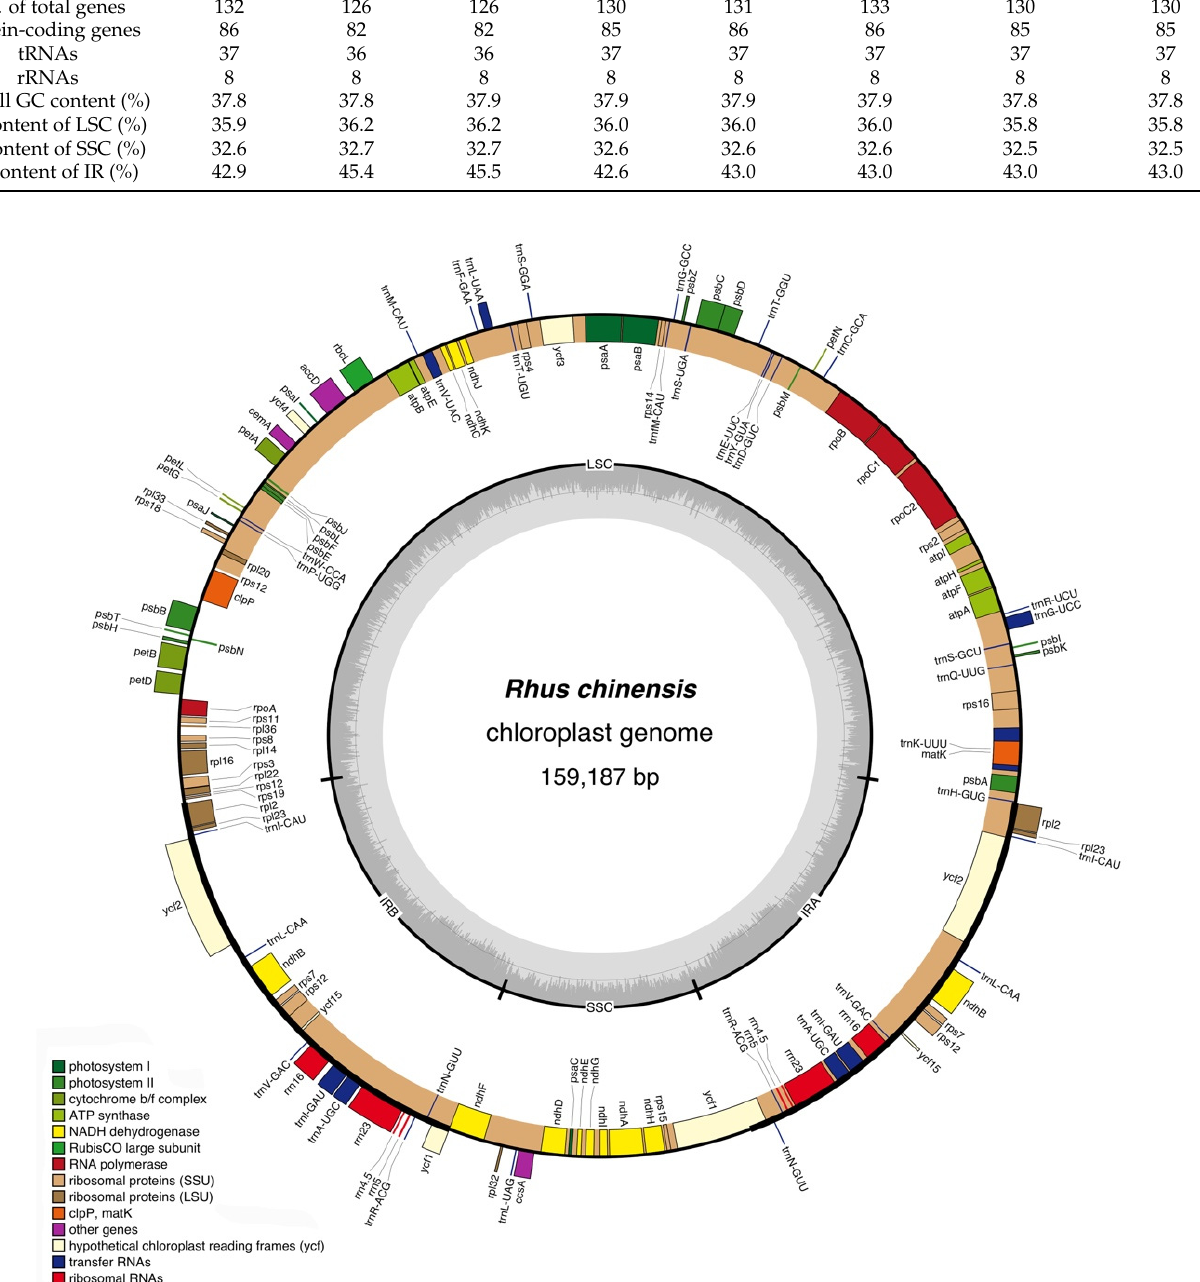
Figure 1. Gene map of the complete chloroplast genome of R. chinensis . The genes inside and outside of the circle are transcribed in clockwise and counterclockwise directions, respectively. The light and darker gray in the inner circle correspond to AT and GC content, respectively.